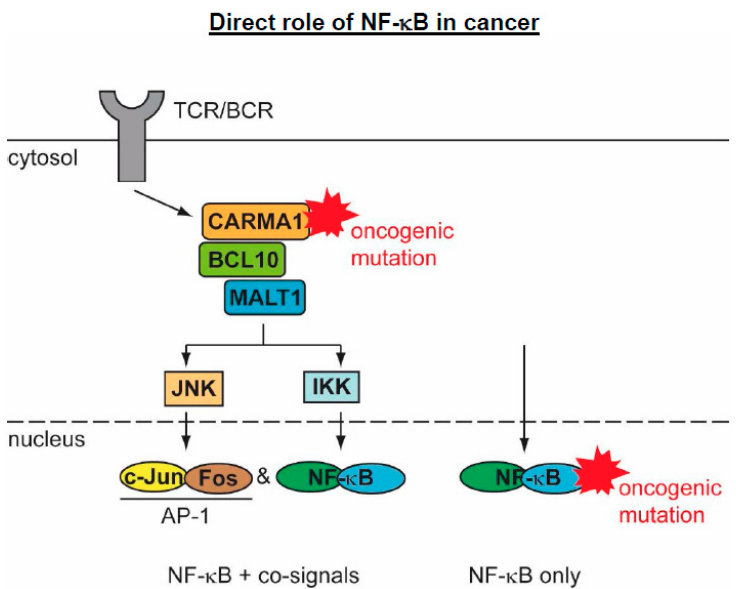
Figure 4. Schematic display of mutations occurring at upstream or downstream components of the NF- κ B system. Mutations of upstream regulators are exemplified by the gain-of-function (GOF) mutations in the CBM complex that typically lead to activation of further tumor-promoting signaling pathways.